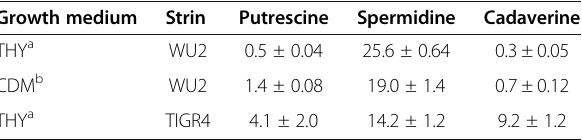
Table 1 Concentration of Intracellular polyamine in